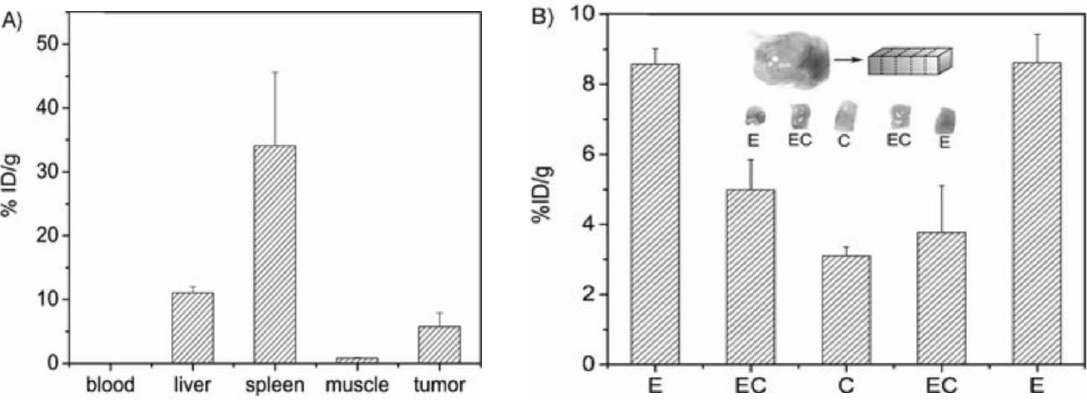
Figure 1: (A) Biodistribution of the AuNC in various organs (B) Distribution of the AuNC within the tumour layers, where E is edge and C is center